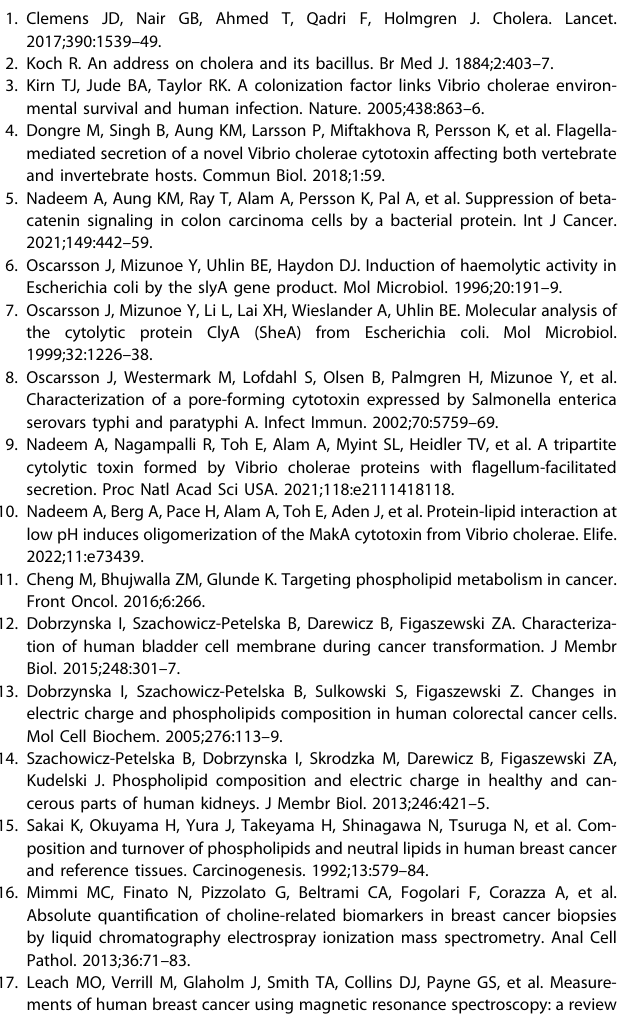
Fig. 6 Effect of MakA in HCT8 cells with PIP5K1 α overexpression and schematic summaries of the MakA effects on PIP5K1 α -mediated signalling. A HCT8 cells were transfected with EGFP-vector control (upper panel) or PIP5K1 α -EGFP (lower panel) plasmids as described in “ Materials and methods ” . For co-localization experiments of MakA and PIP5K1 α , the transfected HCT8 cells were subsequently treated with Alexa568MakA (250 nM, red) for 48 h. Nuclei were counterstained with DAPI (blue). Graphs on the right show fl uorescence intensity pro fi les of the corresponding images along the dotted white lines. Pearson correlation co-ef fi cient was used for calculation of Alexa568MakA (red) co- localization with EGFP or PIP5K1 α -EGFP (green) along the cell membrane. Scale bars = 10 μ m. B Western blot analysis of PIP5K1 α levels in EGFP-vector control or PIP5K1 α -EGFP HCT8 total cell lysates. C Confocal microscopy analysis of vehicle (Veh) or MakA (250 nM) treated (48 h treatment) HCT8 cells transfected with EGFP-vector control or PIP5K1 α -EGFP plasmids. Cells were stained with cell proliferation marker, Ki67 (green). Nuclei were counterstained with DAPI (blue). Effects on HCT8 cell proliferation was assessed by quantifying the number of Ki67- negative cells from eleven individual microscopy fi elds of view (65 – 200 cells per fi eld of view). Signi fi cance was determined using an unpaired t test, ns non-signi fi cant. D Schematic representations showing (i) the downstream signalling of PIP5K1 α during tumour cell proliferation and survival, (ii) the effect of MakA and ISA-2011B